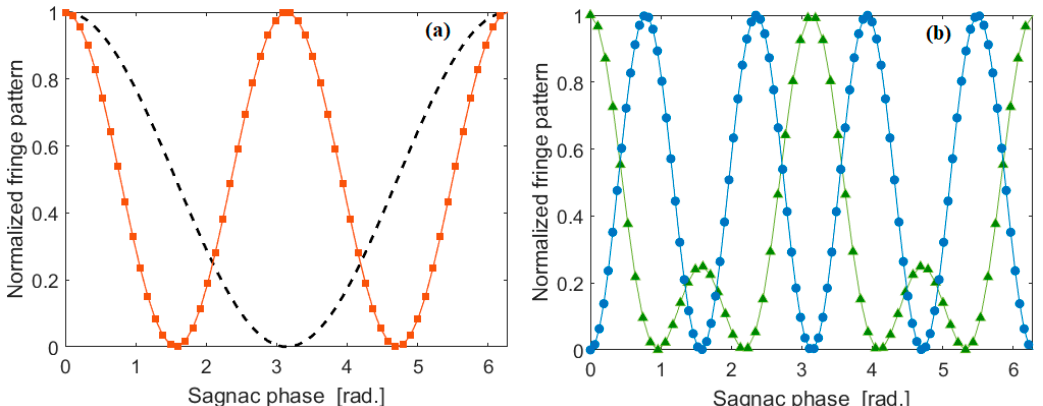
Figure 6. Normalized fringe pattern as a function of the Sagnac phase, for the integrated gyro architectures. ( a ) Dashed line: Classic interference; red square: two photon coincidence, Equation (8) or four-fold coincidence for indistinguishable photons, Equation (12); ( b ) Green triangles: six coincidence for indistinguishable photons, Equation (15); Blue circles: six coincidence for indistinguishable photons, Equation (17).